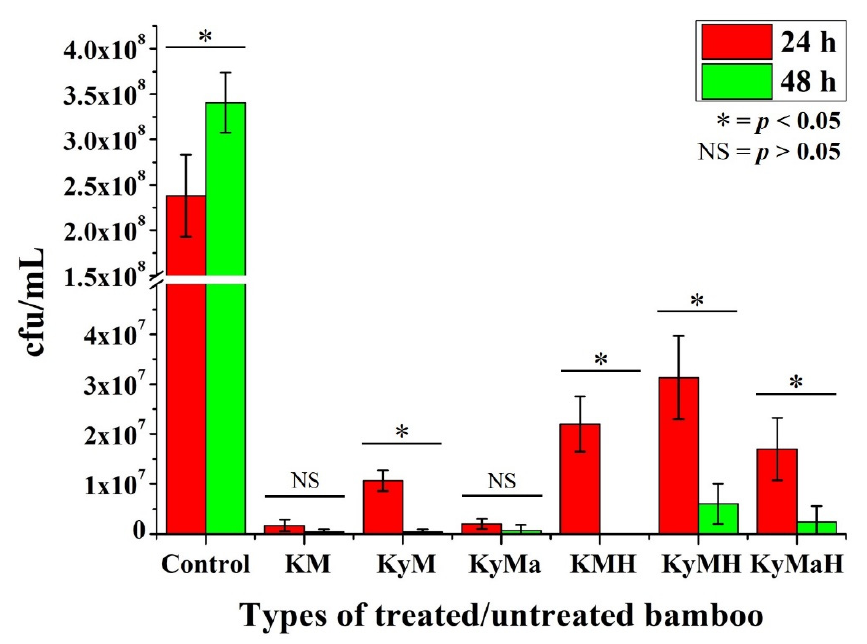
Figure 5. Colony-forming units (CFU) of various types of antibacterial agents of bamboo specimens of varying treatment modifications after in vitro testing with E. coli for a 24 h and 48 h periods (* statistically significant difference, NS = no significant difference).